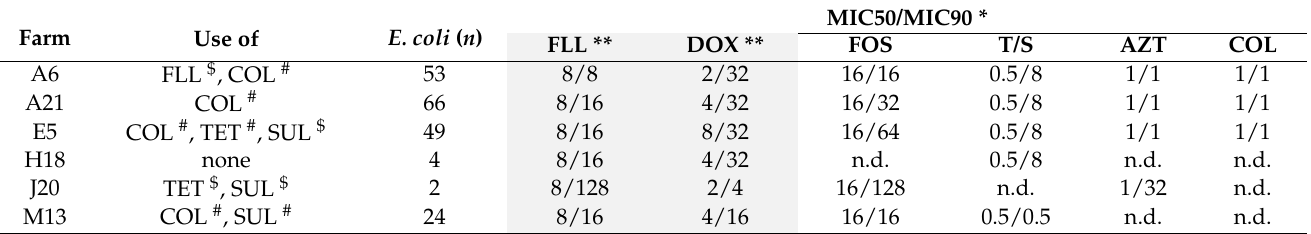
Table 13. Phenotypic susceptibility of meat-borne E. coli against diverse antibiotics.